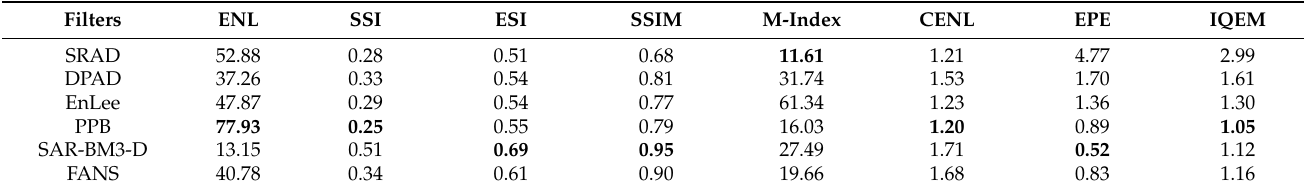
Table 4. Index evaluation of the TerraSAR-X SAR image.